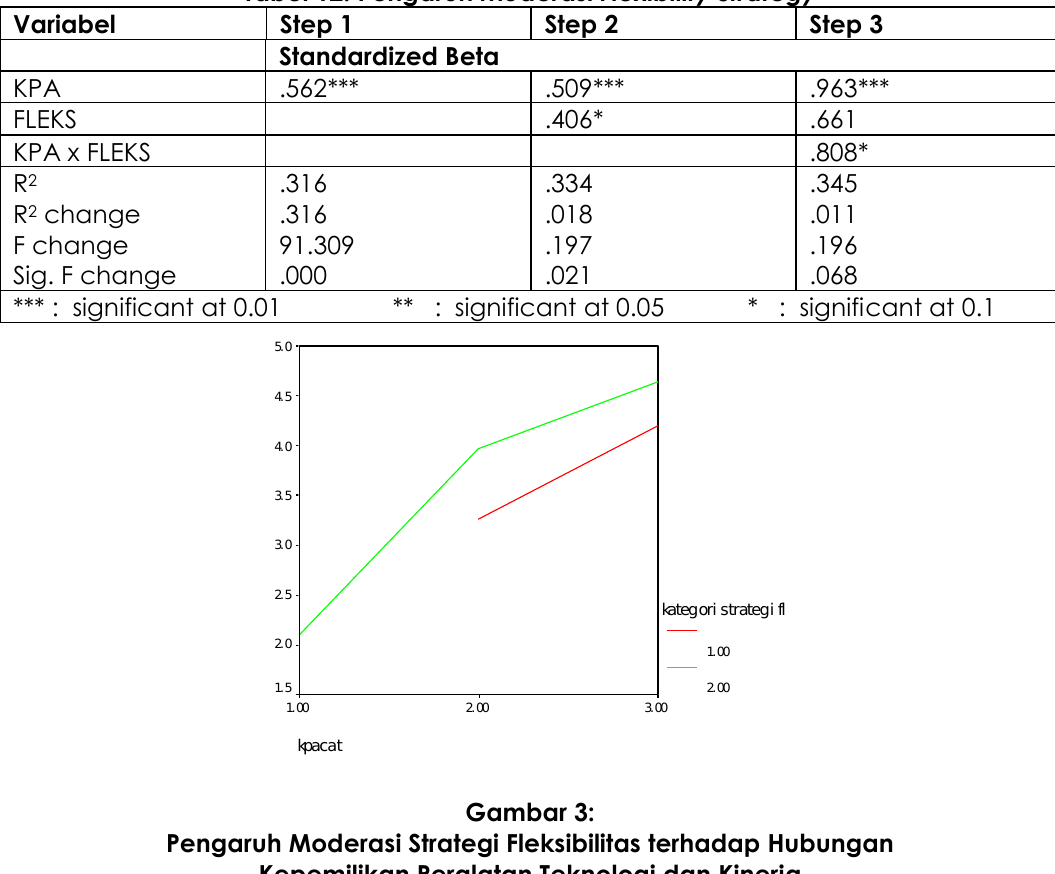
Tabel 12: Pengaruh Moderasi Flexibility